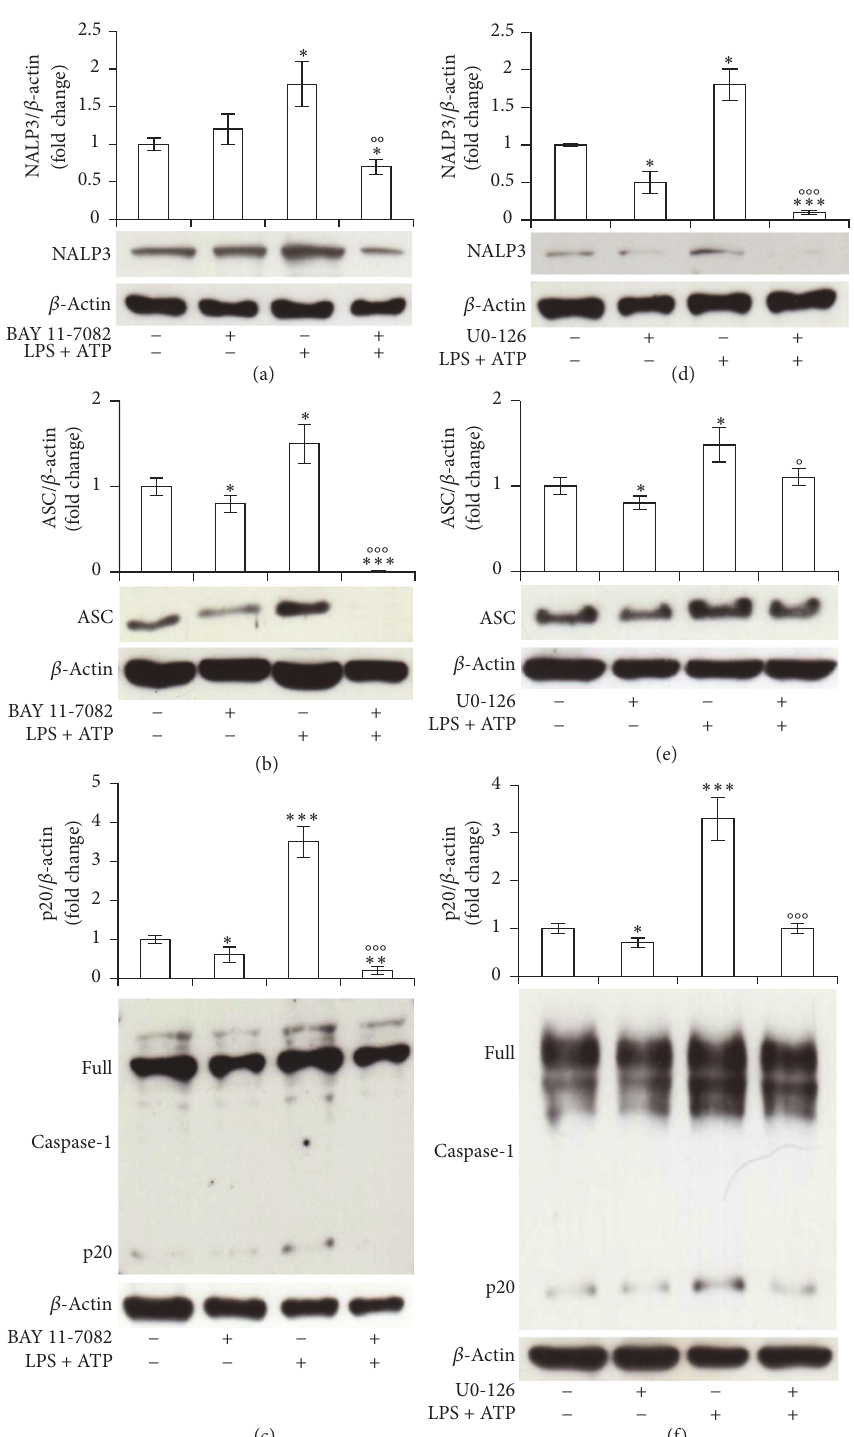
Figure5:NF-kBandERK1/2areinvolvedinNALP3/ASC/Caspase-1cascadeactivationinTHP-1cells.THP-1cellswereincubatedwith10 𝜇 M BAY 11-7082 (a, b, c) or U0-126 (d, e, f) for 1h and then treated with 10 𝜇 g/mL LPS/5 mM ATP for 30 min. Cell lysates were immunoblotted for NALP3 (a, d), ASC (b, e), or Caspase-1 (c, f). The blots were stripped of the bound Ab and reprobed with mouse anti- 𝛽 -actin, to confirm equal loading. Western blots are representative of three separate experiments. Histograms indicate means ± SD of three separate experiments each one tested in triplicate. ∗ 𝑃 < 0.05 , ∗∗ 𝑃 < 0.01 , and ∗∗∗ 𝑃 < 0.001 versus untreated cells and ∘ 𝑃 < 0.05, ∘∘ 𝑃 < 0.01, and ∘∘∘ 𝑃 < 0.001 versus LPS/ATP treated